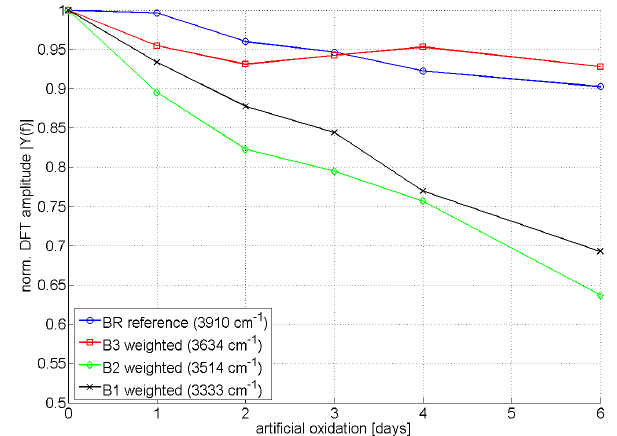
Figure 11. Measurement results for ester-based hydraulic fluid ar- tificially aged at 130 ◦ C with 50cm 3 min − 1 air flow over 6 days, measured with a detector in ester configuration (reference BR).